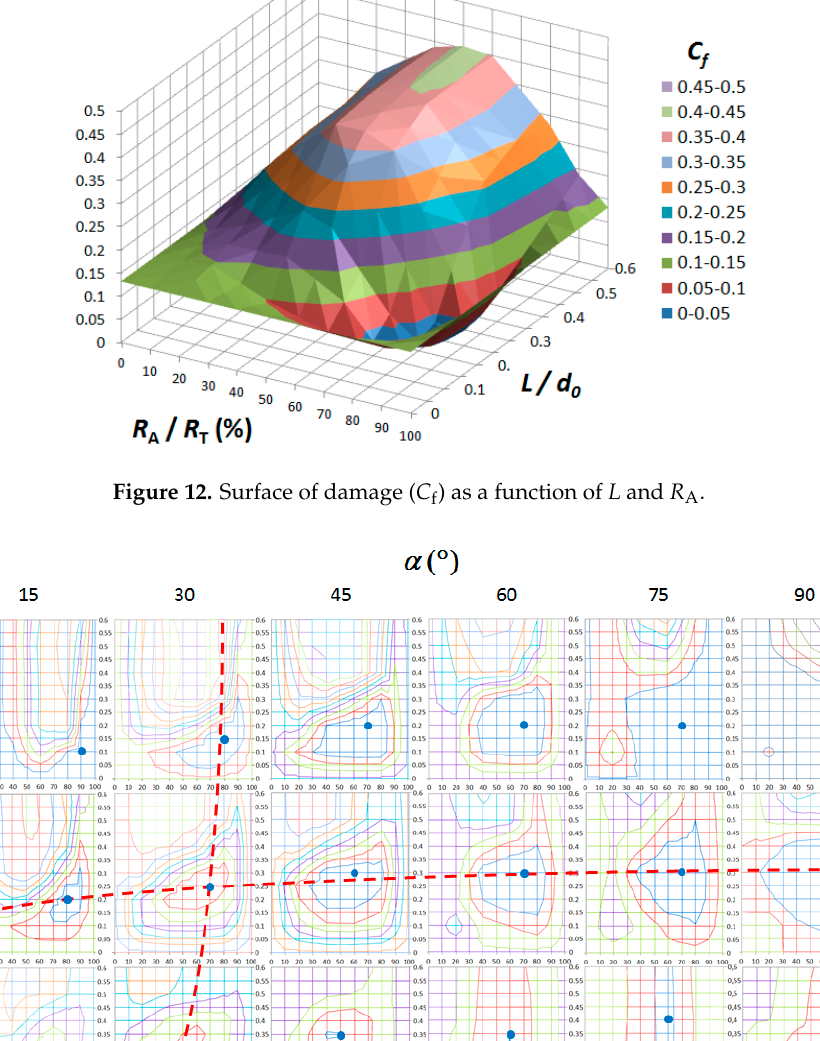
Figure 11. Damage factors ( C f ) and forces versus R A / R T .